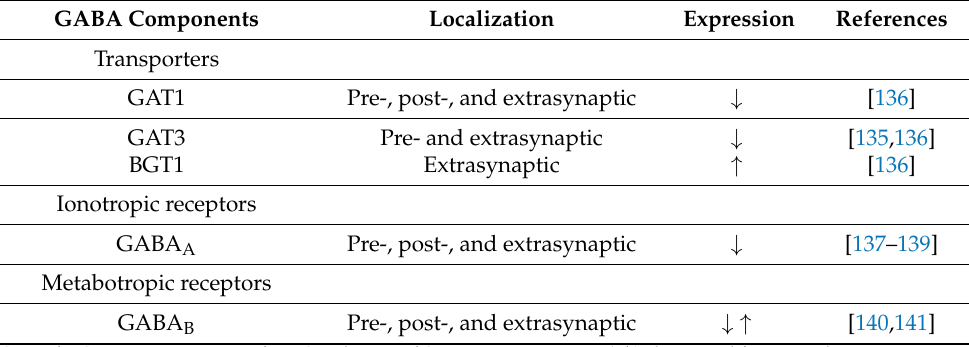
Table 2. Alterations of GABAergic system components in human AD. GABA